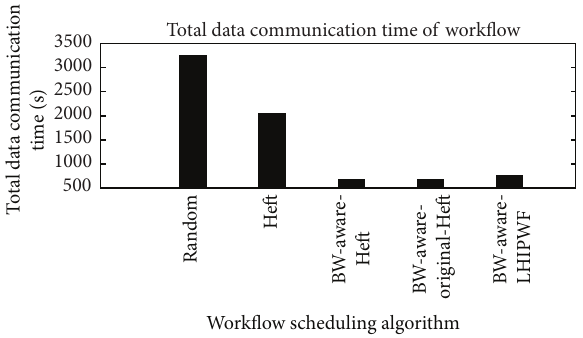
Figure 6: Comparison of the total data communication time for the workflow of 10